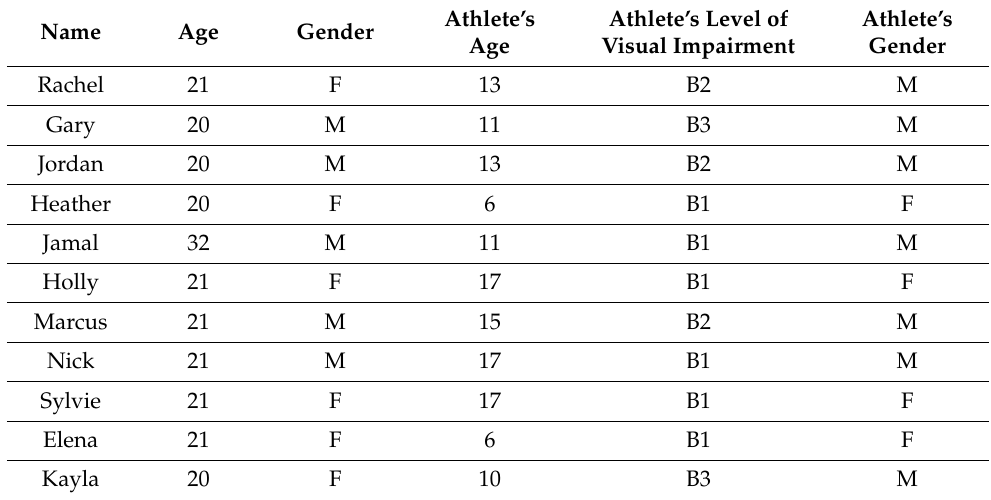
Table 2. Focus Group